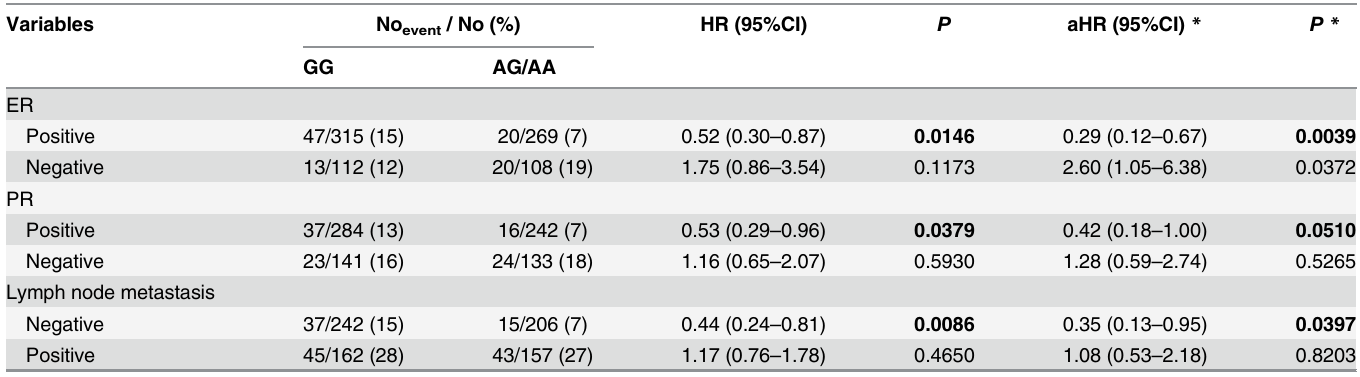
Table 6. Stratified event-free survival analysis of rs7186053 by ER, PR and lymph node status.